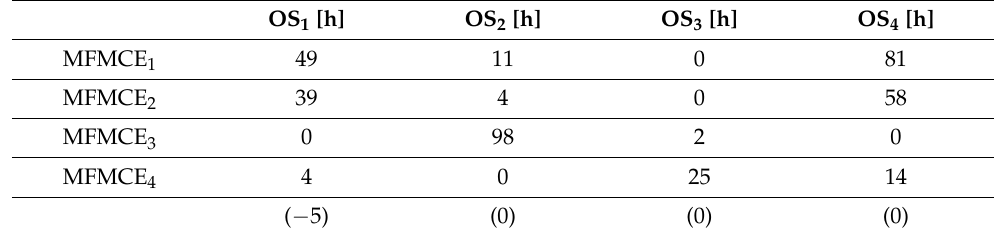
Table 4. Cross combination after column minima subtraction.